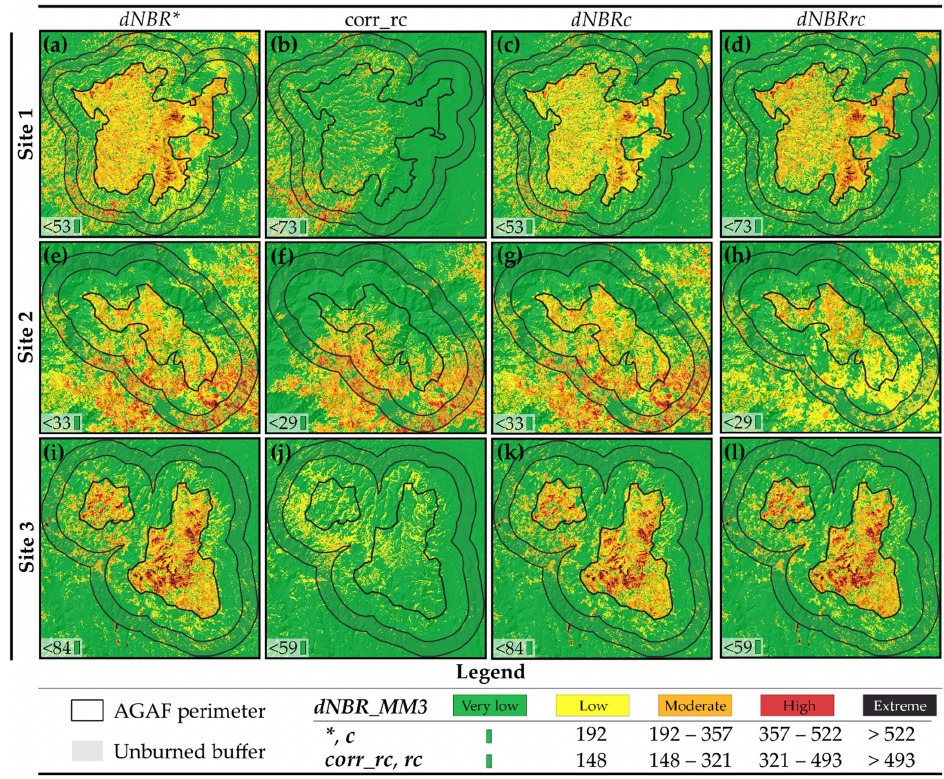
Figure 4. Phenological corrections on dNBR images, where dNBR* = without any correction ( a , e , i ), corr_rc = relative correction map ( b , f , j ), dNBRc = constant-offset-corrected dNBR ( c , g , k ), and dNBRrc = relative-phenology-corrected dNBR ( d , h , l ) for sites 1 ( a – d ), 2 ( e – h ) and 3 ( i – l ). Very low/unburned thresholds (shown in green) were obtained for each fire in Section III (Table 6). Table 6. Overall accuracy, kappa index, sensitivity, and specificity of the best-performing RBR burned area thresholds, for each analyzed composite technique in 1–3 months and different phenological corrections ( c and rc ).